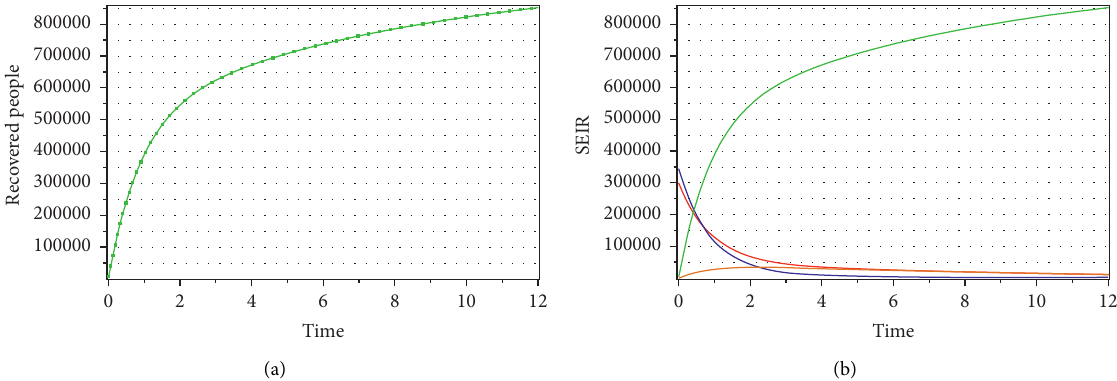
Figure 6: Diagram showing the (a) predicted recovered individuals in Saudi Arabia and (b) overall model of